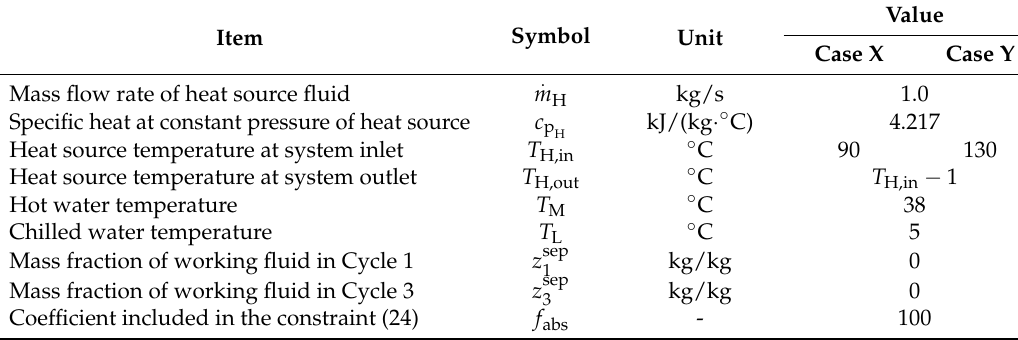
Table 1. Input parameters of the operating properties of working fluids in the case